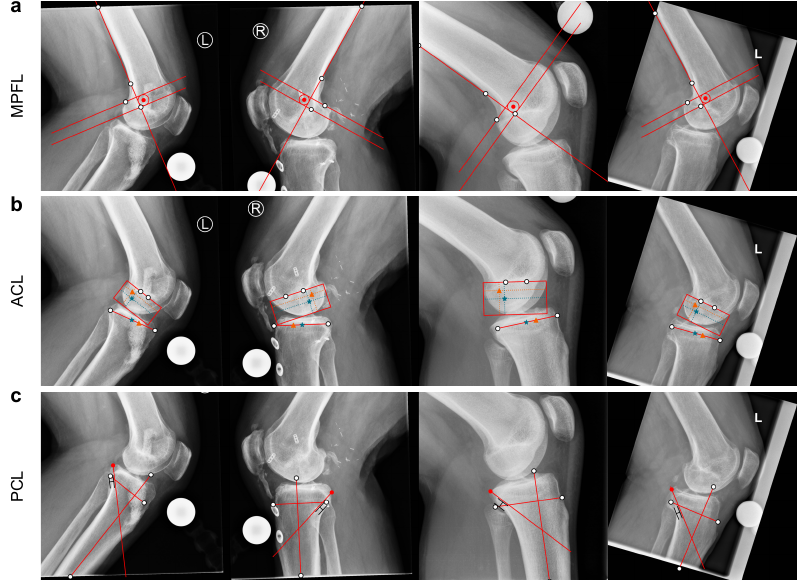
Figure A1. Planning predictions on pre-operative test data with multi-head topology and GradNorm task weighting. ( a ), MPFL. ( b ), ACL. ( c ),